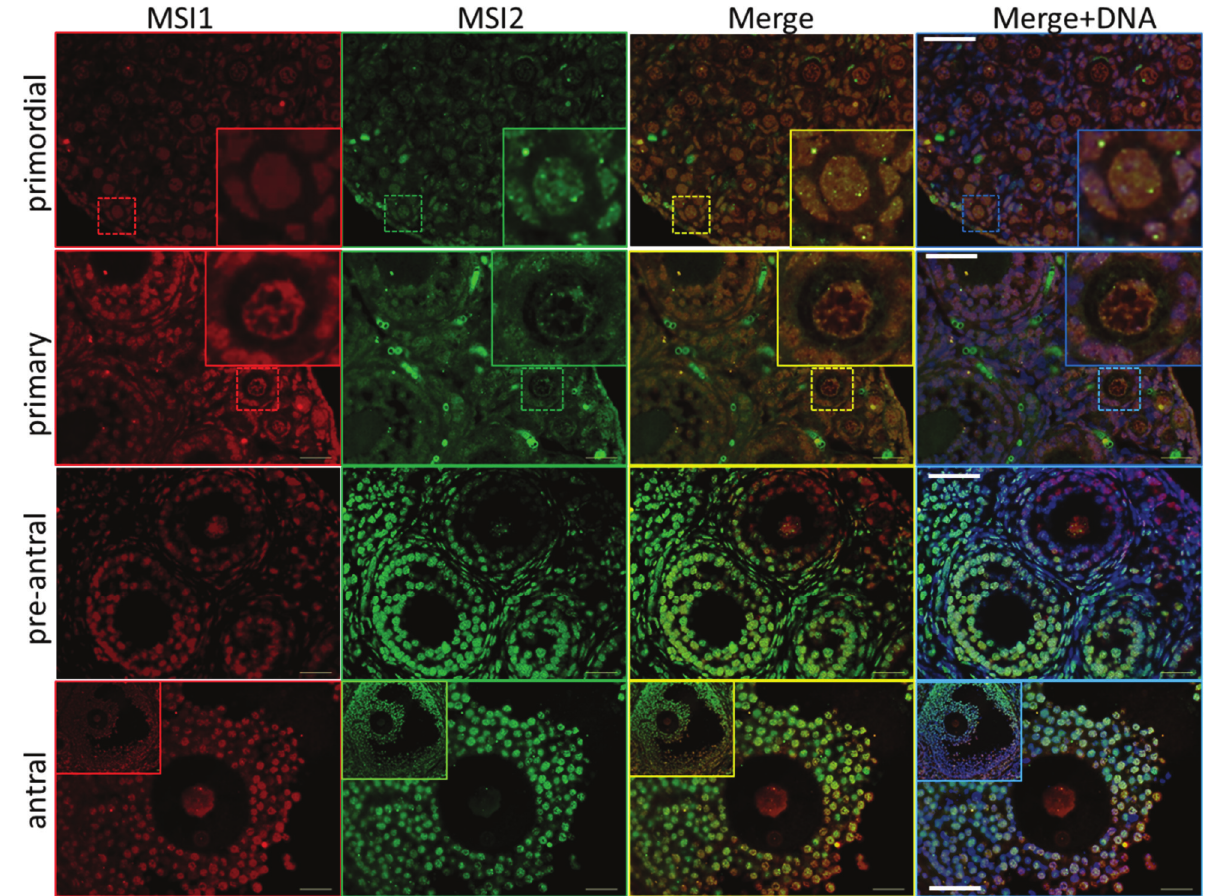
Figure 3. Immunolocalization of Musashi during ovary maturation . Mouse ovary sections were probed for antibodies against MSI1 (red) and MSI2 (green), and counter-stained with DNA marker DAPI (blue). Based on ovary age and follicle composition, images were classified developmentally into primordial, primary, pre-antral, and antral. Sections were visualized via epifluorescent microscopy. Insets in primordial and primary sets show zoomed image of follicle-type. Scale bar in merged images = 40